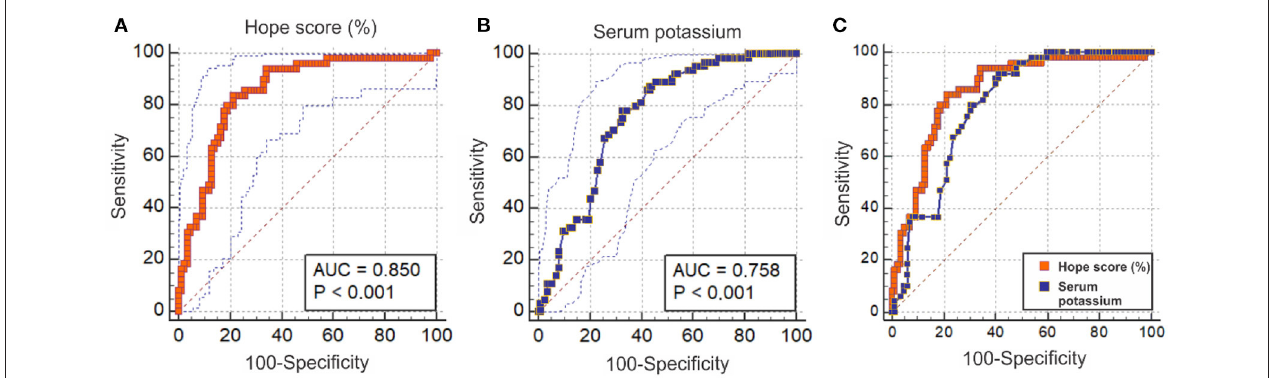
FIGURE 4 | Predictive ability of surviving attempted resuscitation from hypothermic cardiac arrest assessed by ROC curves and AUC by HOPE score and serum K + . (A) Displays Hope score (red) %. AUC 0.85 (CI 95% 0.78–0.91). (B) Shows serum concentration of K + (blue) predicting probability of surviving. AUC 0.79 (CI 95% 0.72–0.86). (C) Depicts the difference between the AUC areas in curves (A) (red) and (B) (blue) of 0.056 ( P =